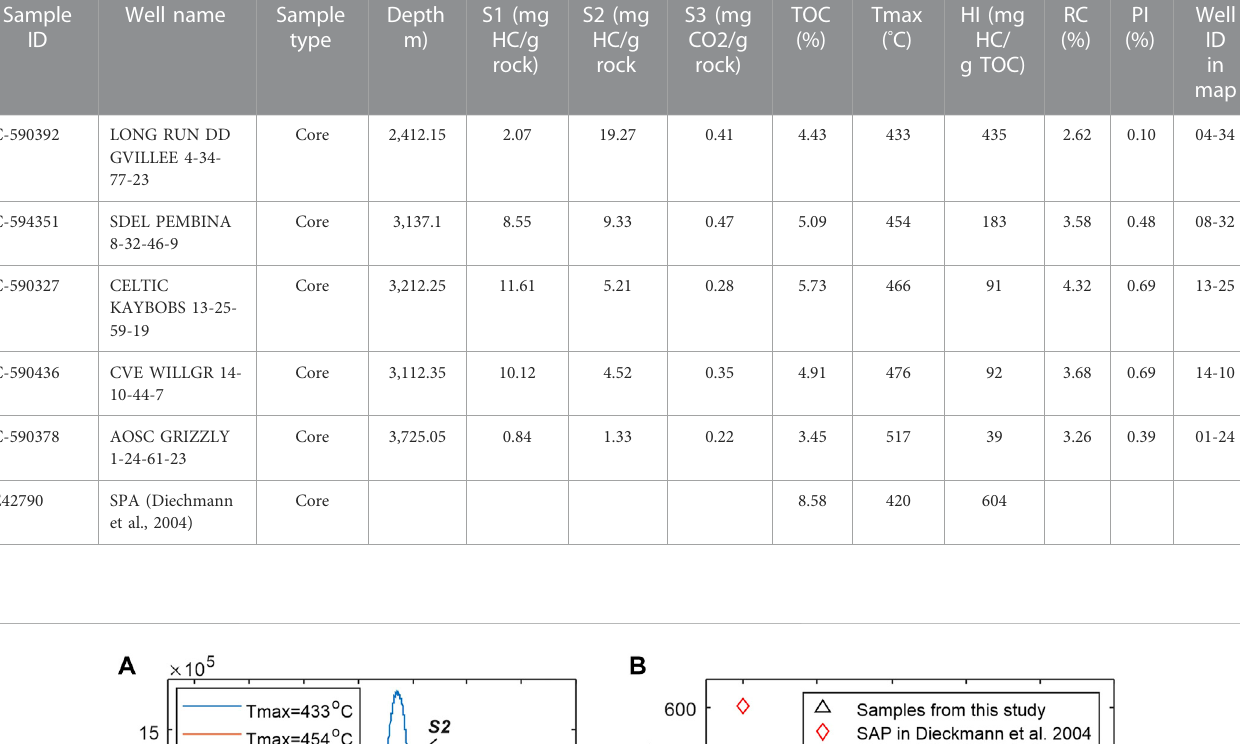
TABLE 1 Rock-Eval analysis results of the fi ve core samples from Upper Devonian Duvernay Formation in WCSB. Sample ID